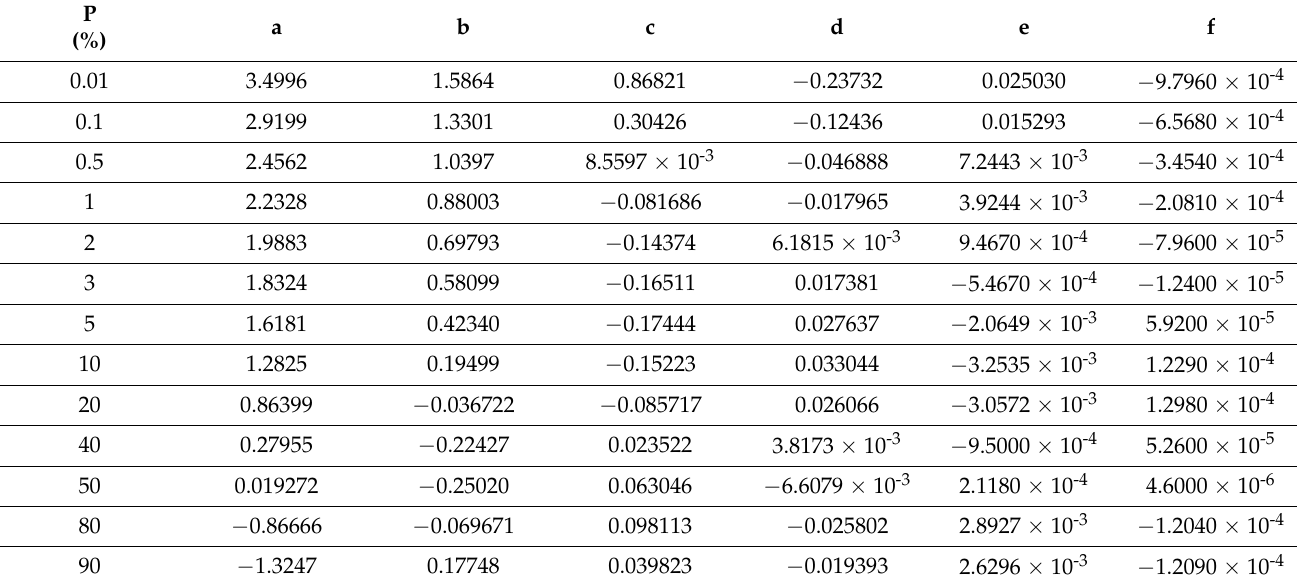
Table A4. The frequency factor for estimation with MOM for pseudo-Weibull.